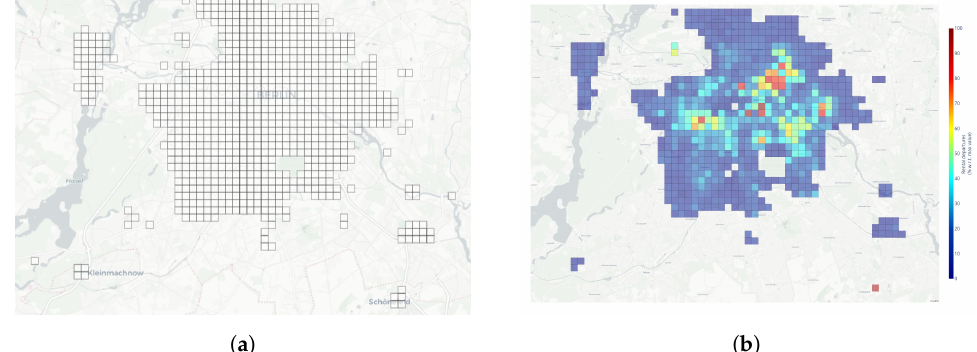
Figure 2. Spatial stratification of the Berlin city map. ( a ) spatial grid built on top of the city map; ( b ) spatial distribution of rental